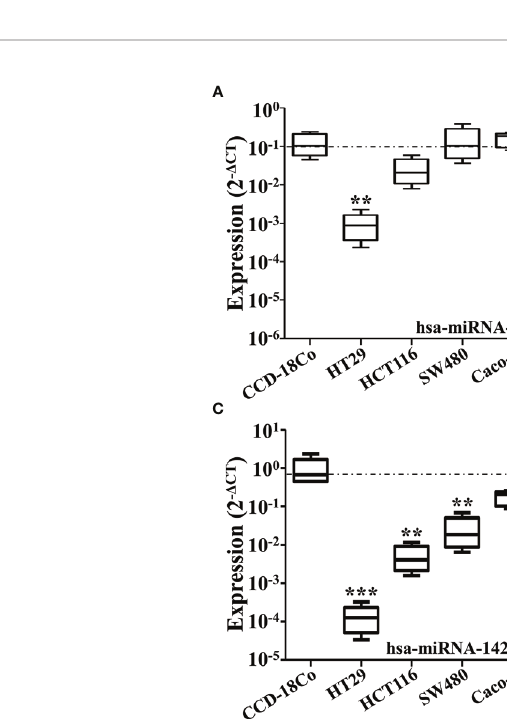
FIGURE 2 | The expressions of miR-150, miR-342-3p, and miR-142-3p are down-regulated in various colorectal cancer cell lines. The qRT-PCR analysis revealed the expression levels of miR-150 (A) , miR-342-3p (B) and miR-142-3p (C) in several colon cancer cell lines including HT29, HCT116, SW480 and caco-2, compared with a human colon fi broblasts CCD-18Co. (D) The expression of miR-142-3p was be measured in the HT29 and HCT116 cells transduced with synthetic miRNA mimics. All data are shown as means ± SD. * and ** represent signi fi cant difference as p < 0.05 and 0.01